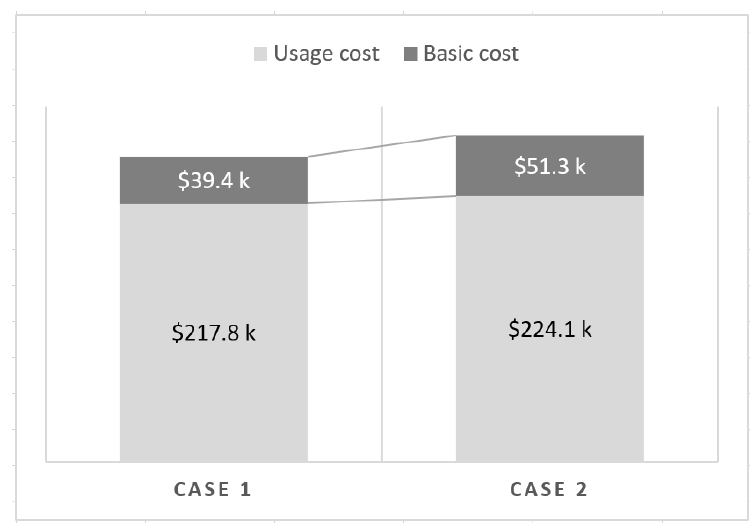
Figure 3. A comparison of the energy purchase costs in Case 1 and Case 2.